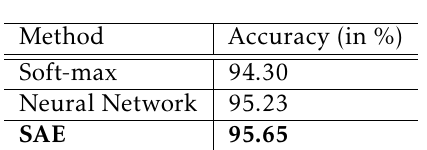
Table 7. Classification accuracy comparison among soft-max,